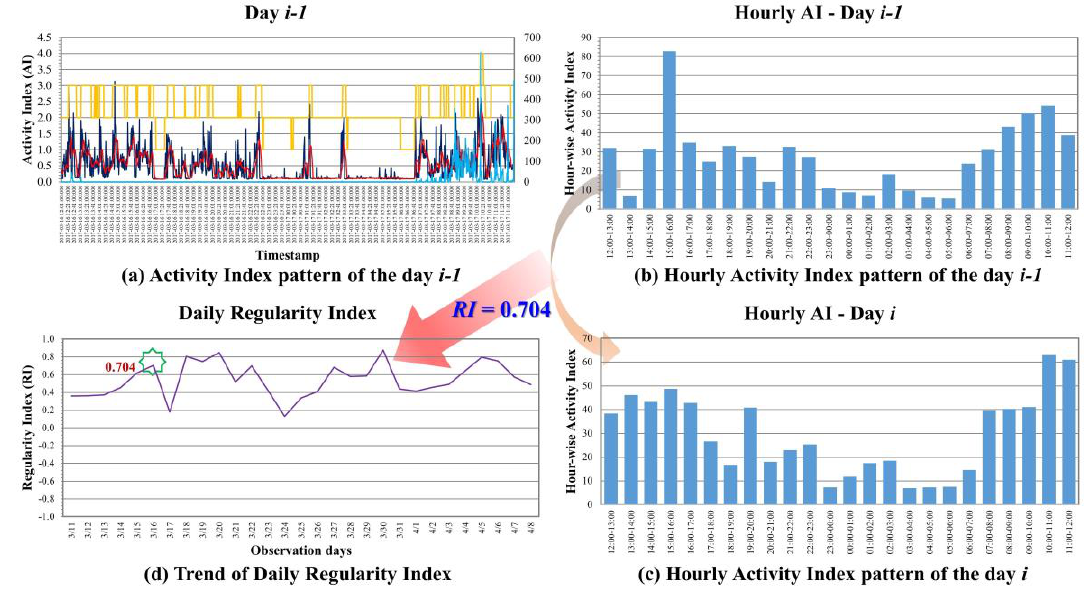
Figure 6. ( a ) Minute-wise AI pattern of day i − 1 ; ( b ) hourly AI pattern of day i − 1 ; ( c ) hourly AI pattern of day i; and ( d ): RI trend.